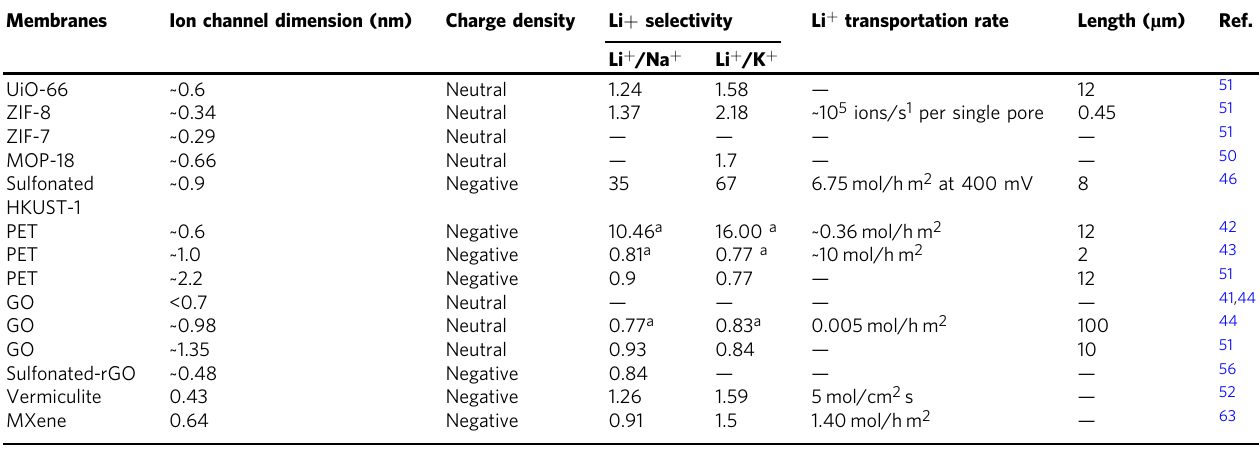
Table 1 Comparison of nanostructured based Li + ions selective membranes that are reported in literature. Membranes Ion channel dimension (nm) Charge